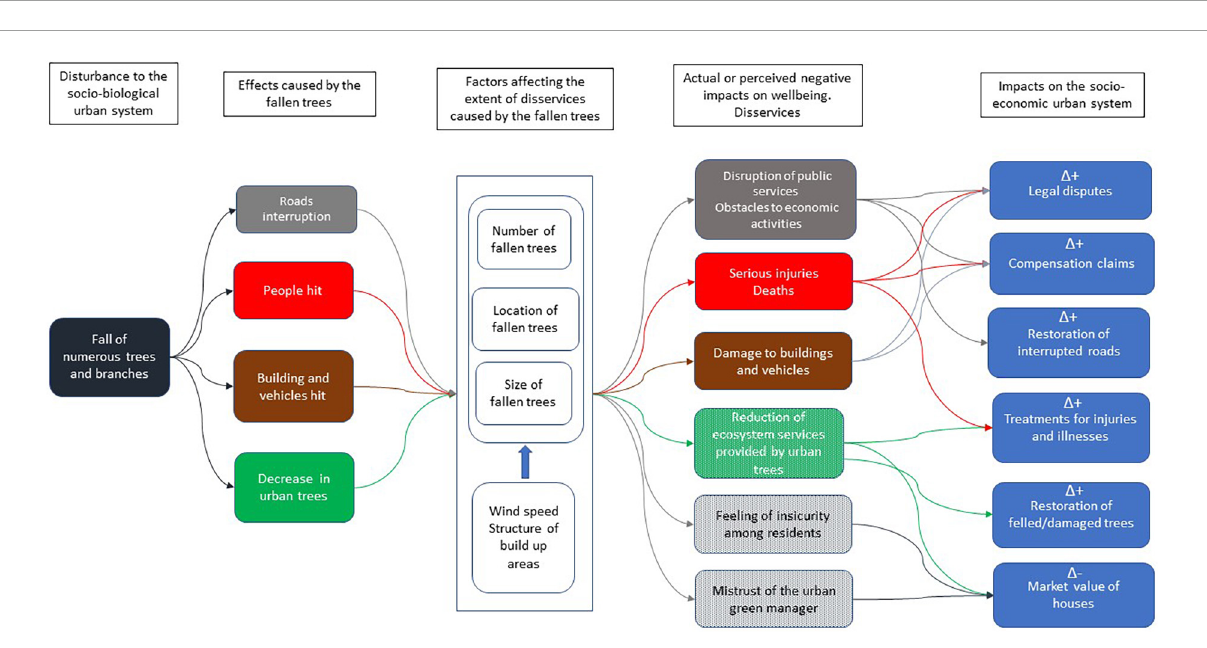
FIGURE2 Detailed conceptual model of ecosystem disservices caused by the fall of numerous urban trees. The colors connect the different effects of falling trees with the generated disservices. In light gray boxes are the disservices attributable to all four effects and the extent of which will depend on the response of the urban green manager. The finely dotted background indicates that the disservice will manifest over the time following the disturbance event (see text for more